Question: Briefly state, in one sentence, what is plotted here.
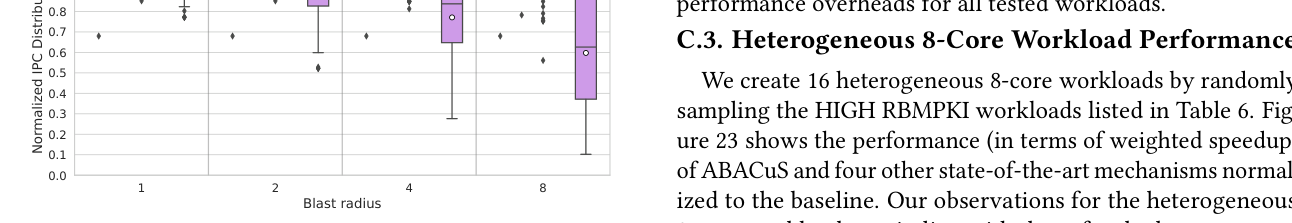
Answer: Normalized performance (distribution) of single- core applications with varying blast radius for ABACuS and four state-of-the-art mechanisms. We perform this analysis for a RowHammer threshold of 1000.